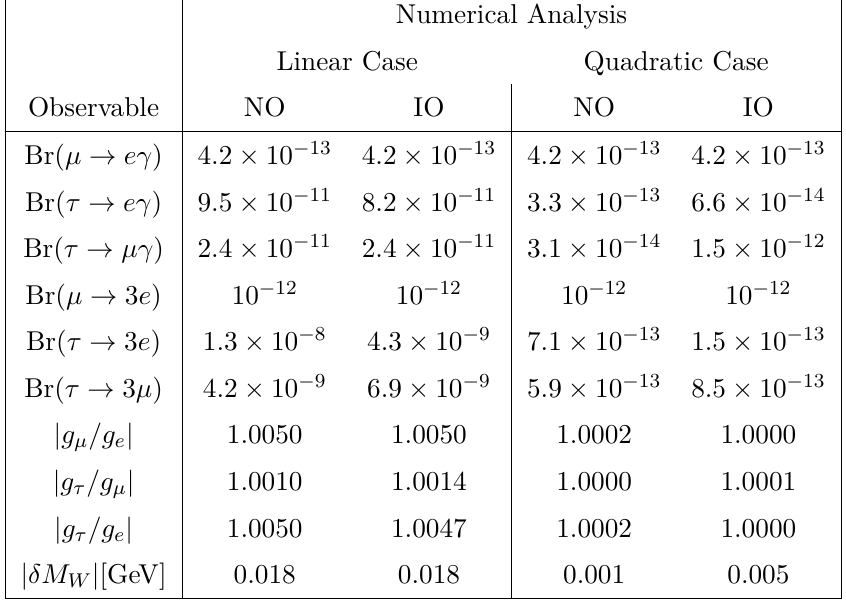
Table 2 . (lower table only) The upper table contains the current experimental bounds on and future sensitivities to the relevant observables. The lower table shows the respective maximum contribution found in the scan in the linear case and the quadratic case for either neutrino-mass